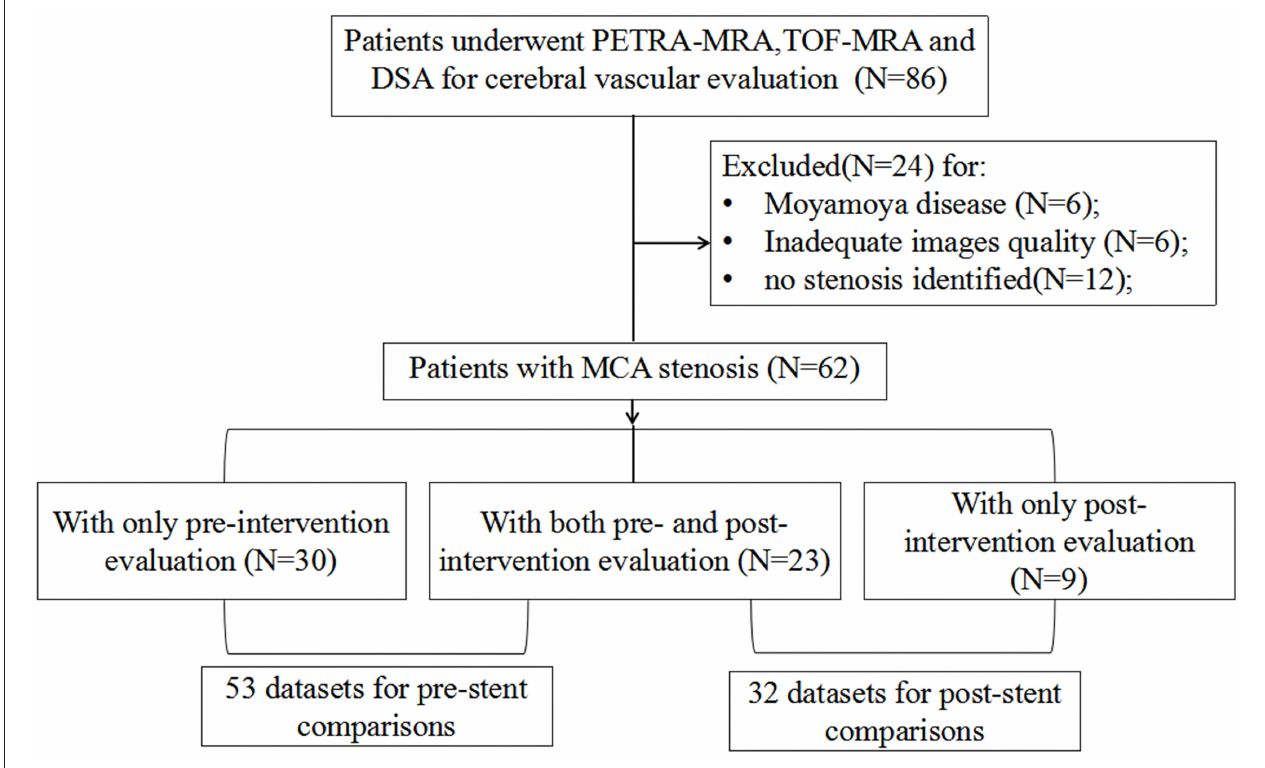
FIGURE 1 | Patient selection flowchart.